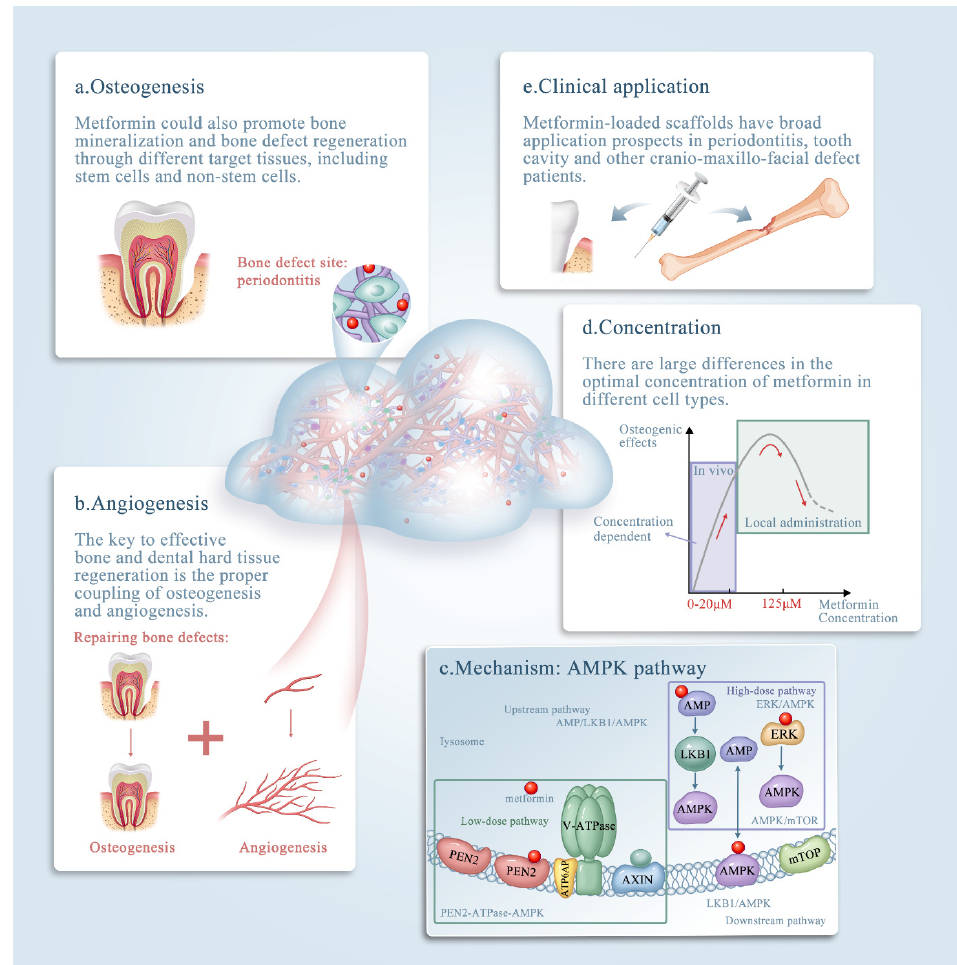
Figure 1. The roles of metformin in bone tissue engineering. The effects of metformin in bone tissue engineering. The promising clinical application metformin could contribute to diagnosis and treatment of bone defects. ( a – e ) Schematic illustrating metformin delivery via biomaterials, mainly via scaffolds, and its effects on bone and dental tissue engineering. Note that metformin exerts its effects by: ( a ) enhancing osteogenesis; ( b ) enhancing angiogenesis; ( c ) affecting the AMPK pathway; and ( d ) acting in a concentration-dependent manner. ( e ) The clinical applications of metformin. The underlying mechanism of metformin (through the AMP-activated kinase (AMPK) signaling pathway) is discussed in detail in the